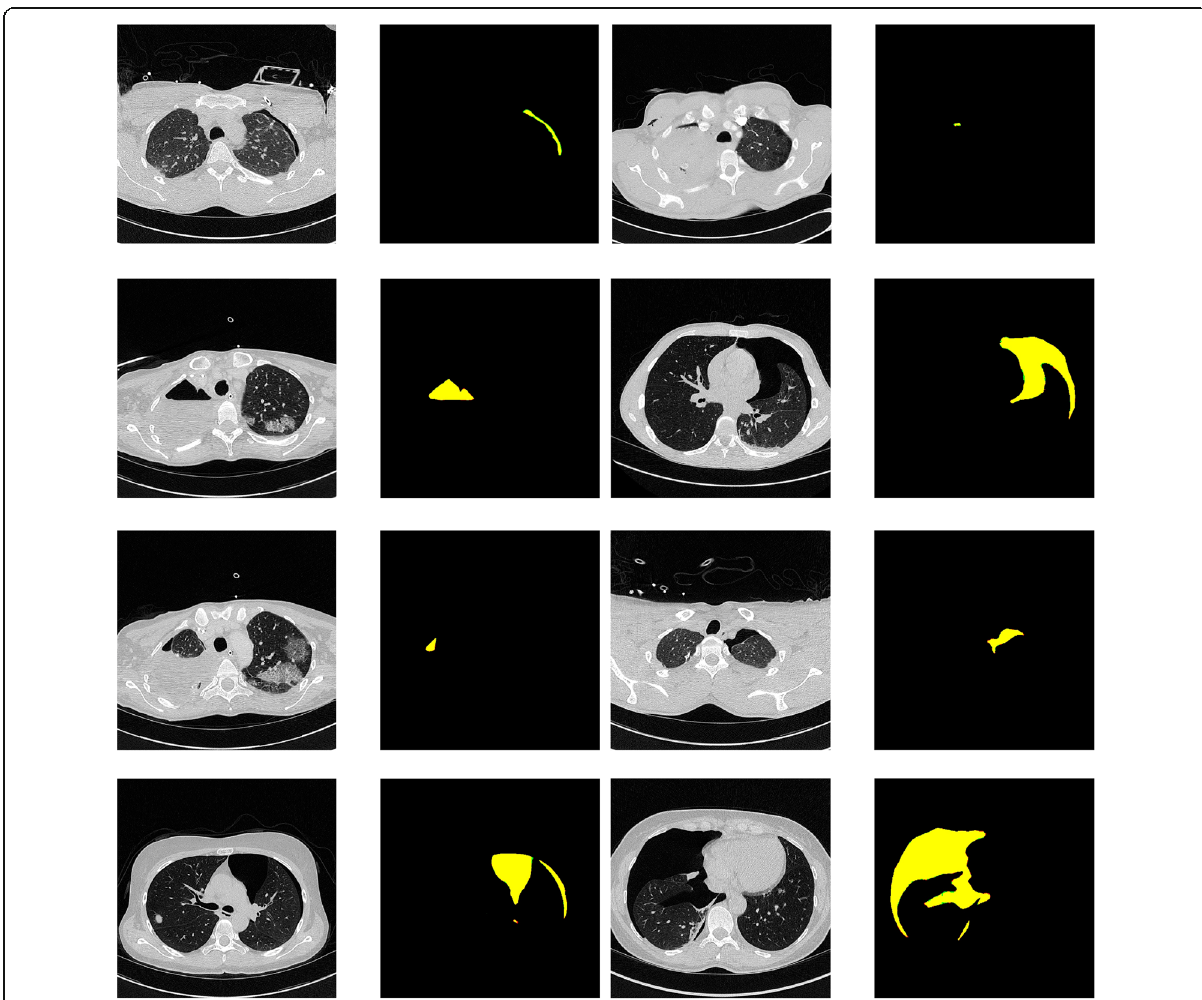
Fig. 4 Segmentation results. Raw images and corresponding segmentation results. False-negatives (red), false-positive pneumothorax predictions (green), and correct pneumothorax predictions (yellow) The areas of false prediction are very subtle and correspond to a few pixels on the edges of the correct yellow predictions. In the next Figure (Fig. 5), in contrast, the areas of false prediction are shown more